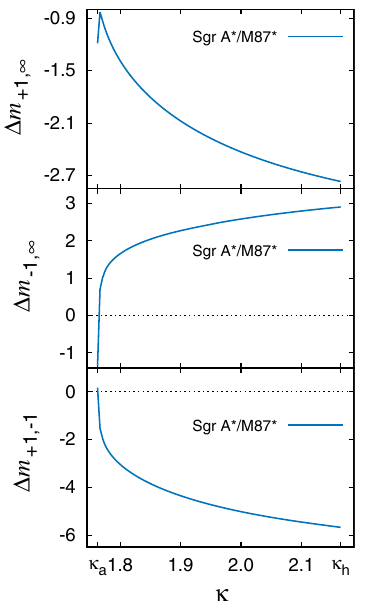
Fig. 4 The magnification-related observables, the brightness differ- ences between relativistic images Δ m + 1 , ∞ , Δ m − 1 , ∞ and Δ m + 1 , − 1 , are shown from top to bottom